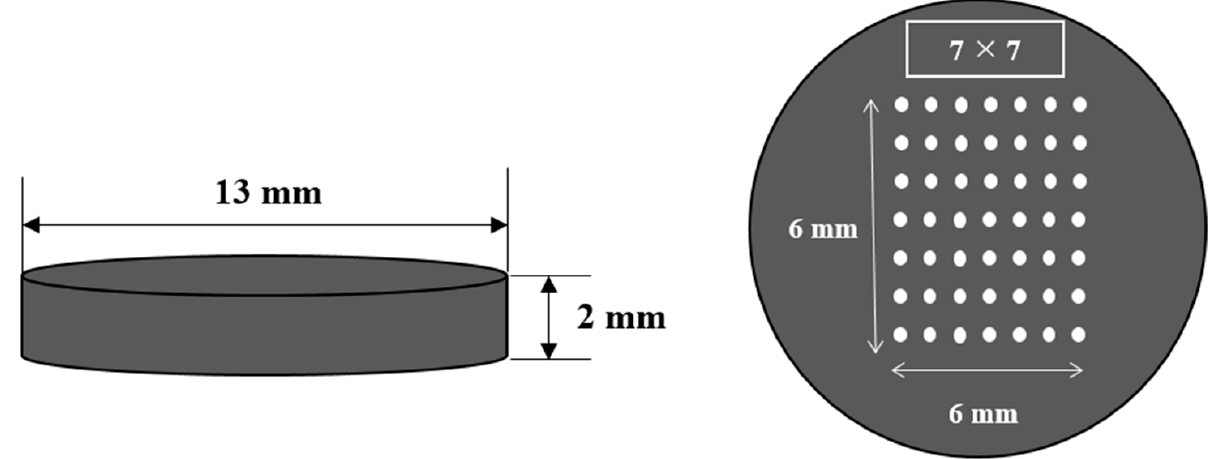
Figure 2. Mixed coal sample pellet. Figure 2.